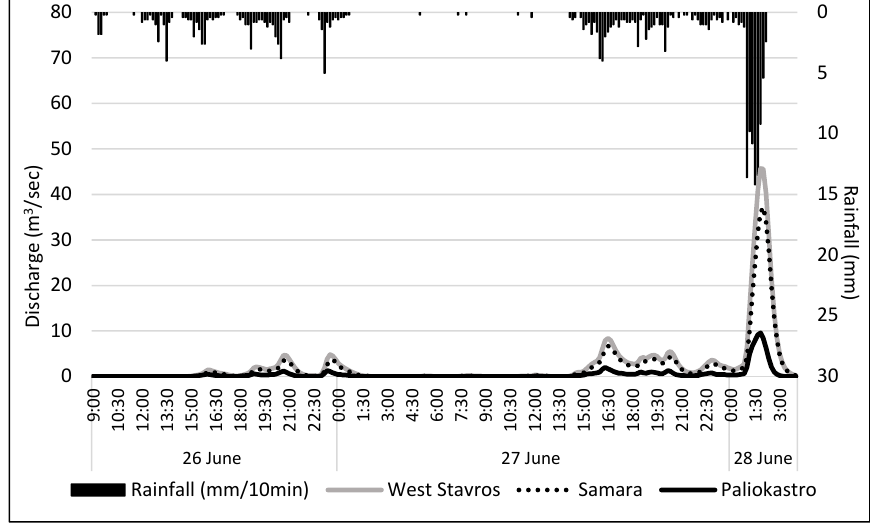
Figure 15. Simulated hydrographs of the June 2018 flood event at Samara and Paliokastro streams (west Stavros).